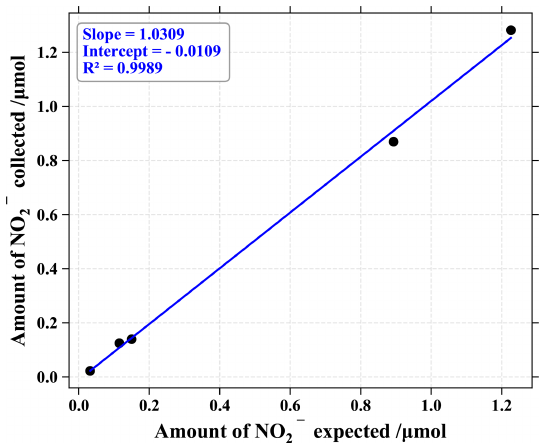
Figure 1. Correlation plot of NO 2 collected on the first denuder tube of the sampling cartridge vs. NO 2 produced by the gas standard